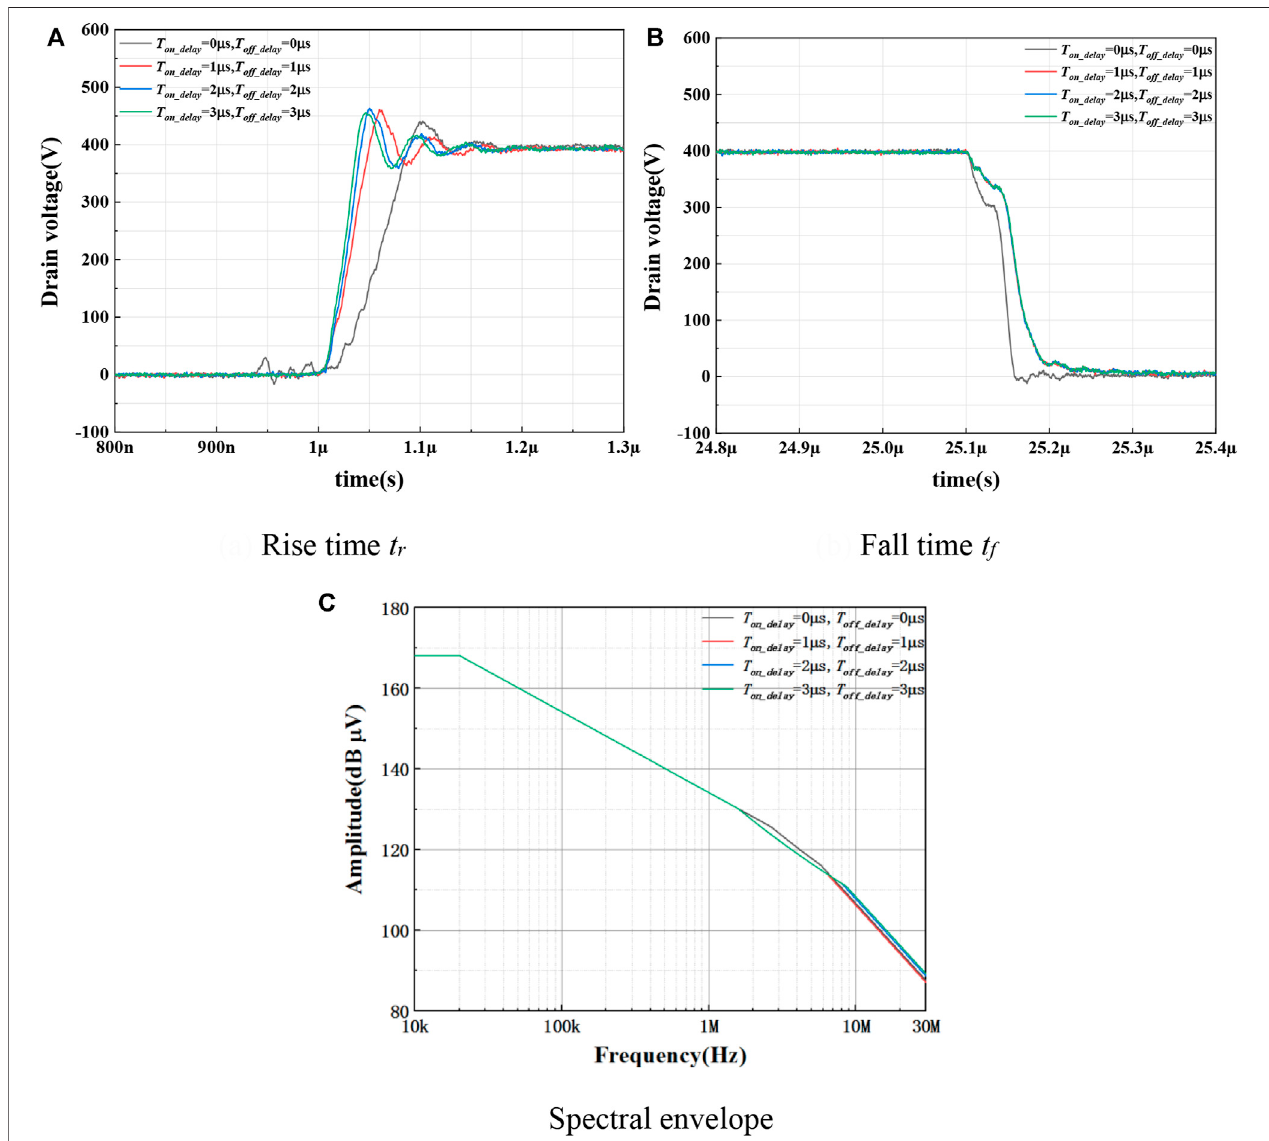
FIGURE 9 | Waveforms of CM voltage and its spectral envelope at different T on_delay and T off_delay (pattern 2). (A) Rise time tr, (B) fall time tf, and (C) spectral envelope.